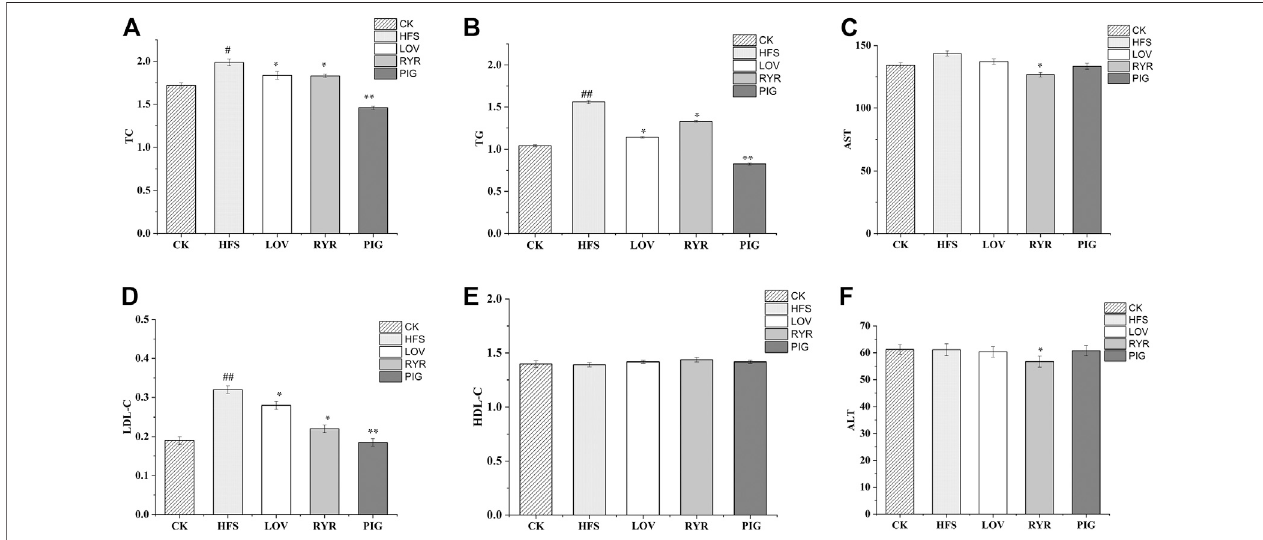
FIGURE 2 | Determination results of blood lipid indexes of different groups of rats (n (cid:2) 8).